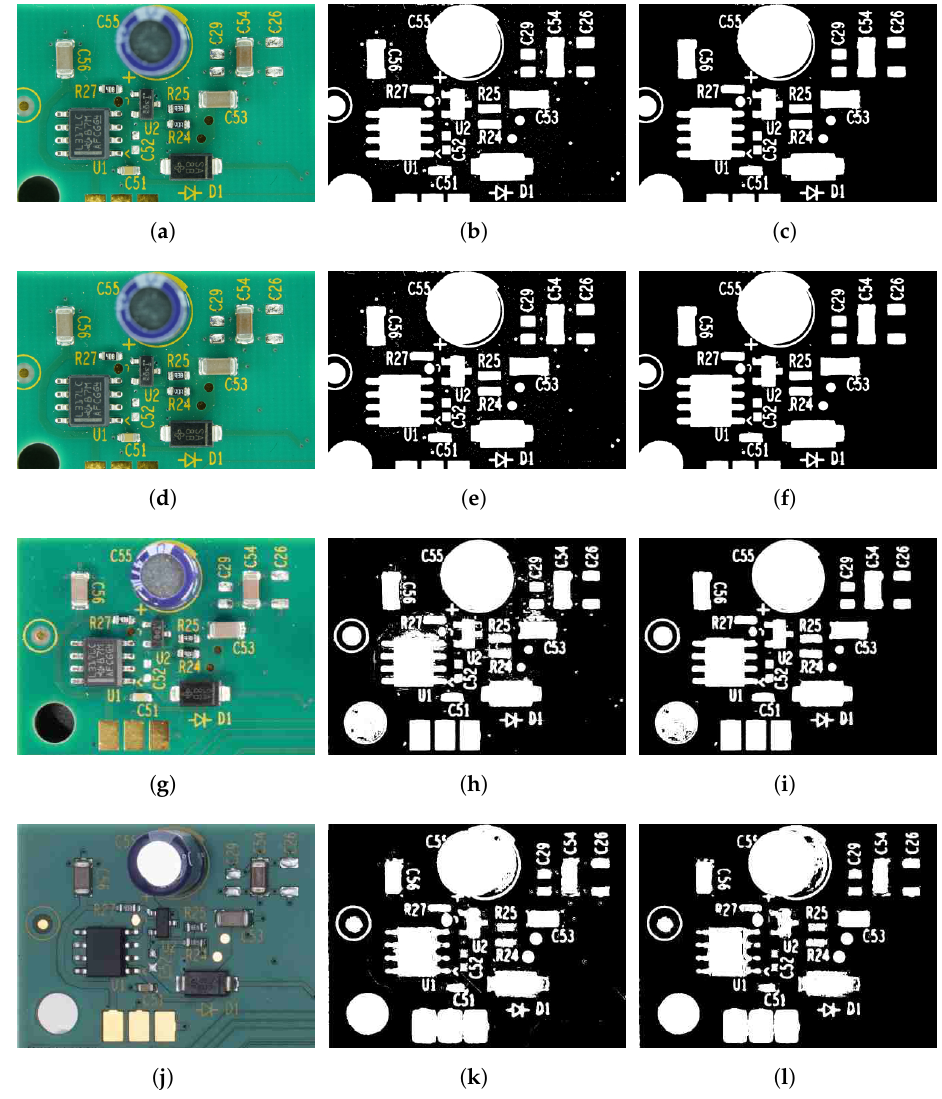
Figure 9. Global and local thresholding results with varying image resolution. Left column ( a , d , g , j ): input PCA board image. Centre column ( b , e , h , k ): global thresholded image. Right column ( c , f , i , l ): local thresholded image. Image resolutions: ( a ) 41.9 MP, ( d ) 10.1 MP, ( g ) 1.9 MP, ( j ) 0.6